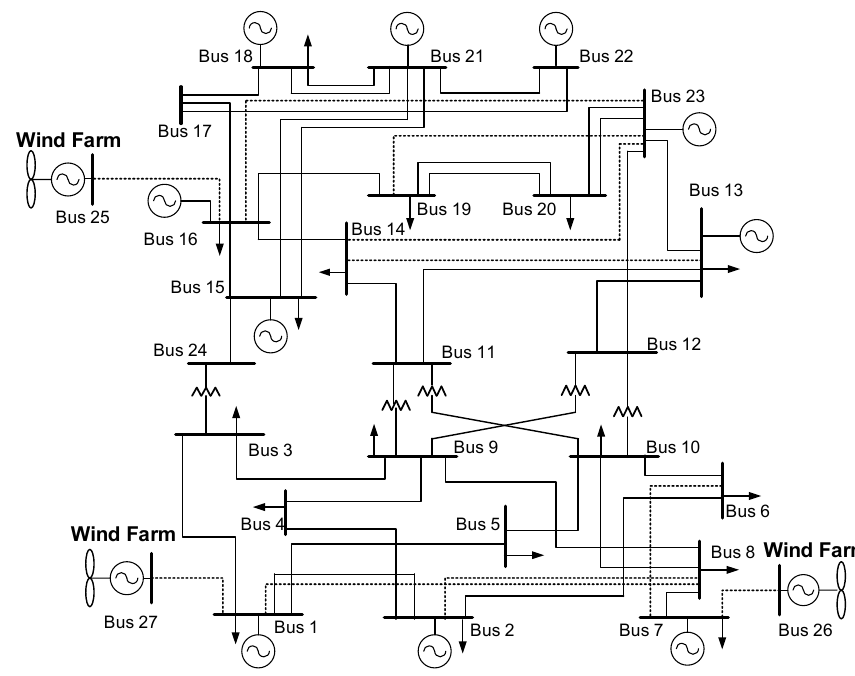
Figure 5. Network topology of the modified IEEE RTS-24 system.